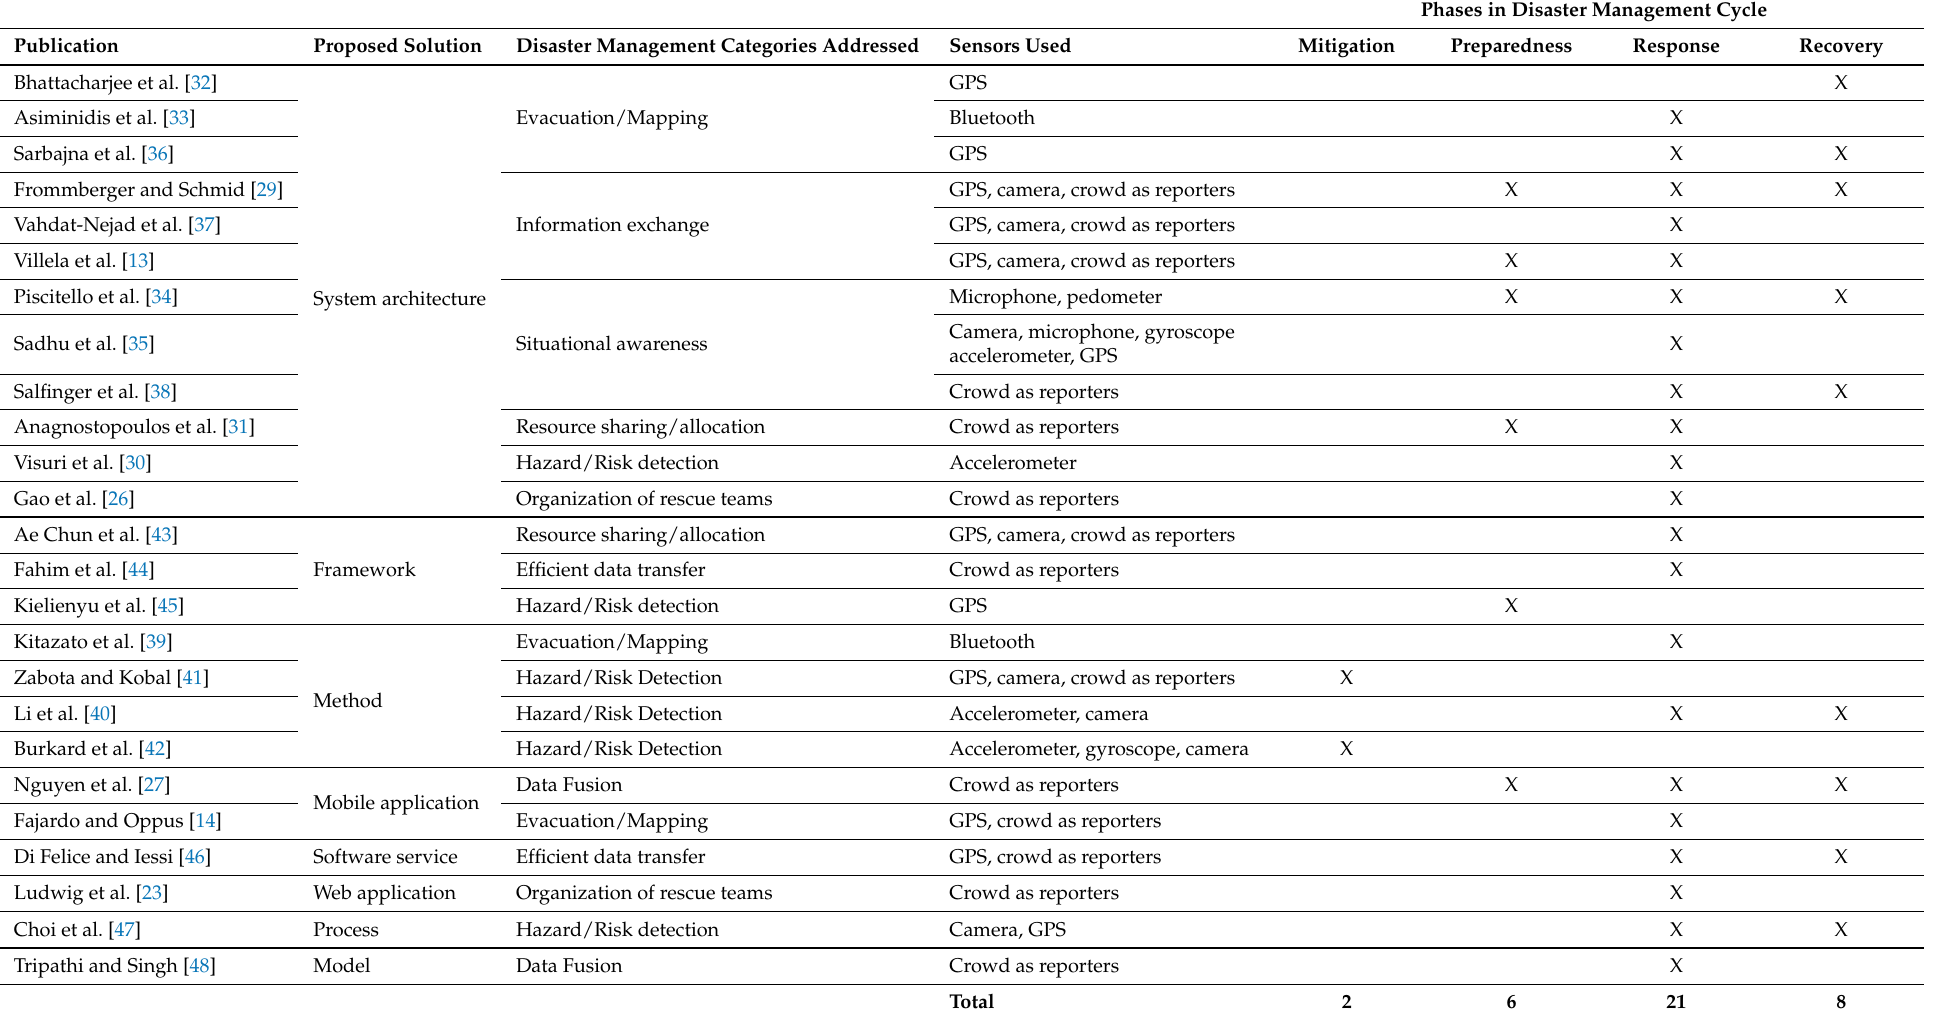
Table 2. List of the Reviewed